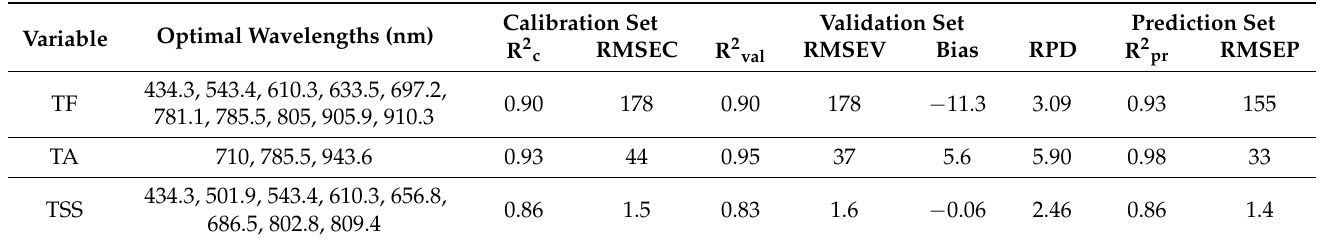
Table 4. Performance of MLR models for predicting Total Flavonoids (TF), Total Anthocyanins (TA), and the Total Soluble Solids (TSS) using the optimal wavelengths extracted from VIPs of the best PLS full spectra analysis. Calibration Set Validation Set Prediction Variable Optimal Wavelengths (nm)